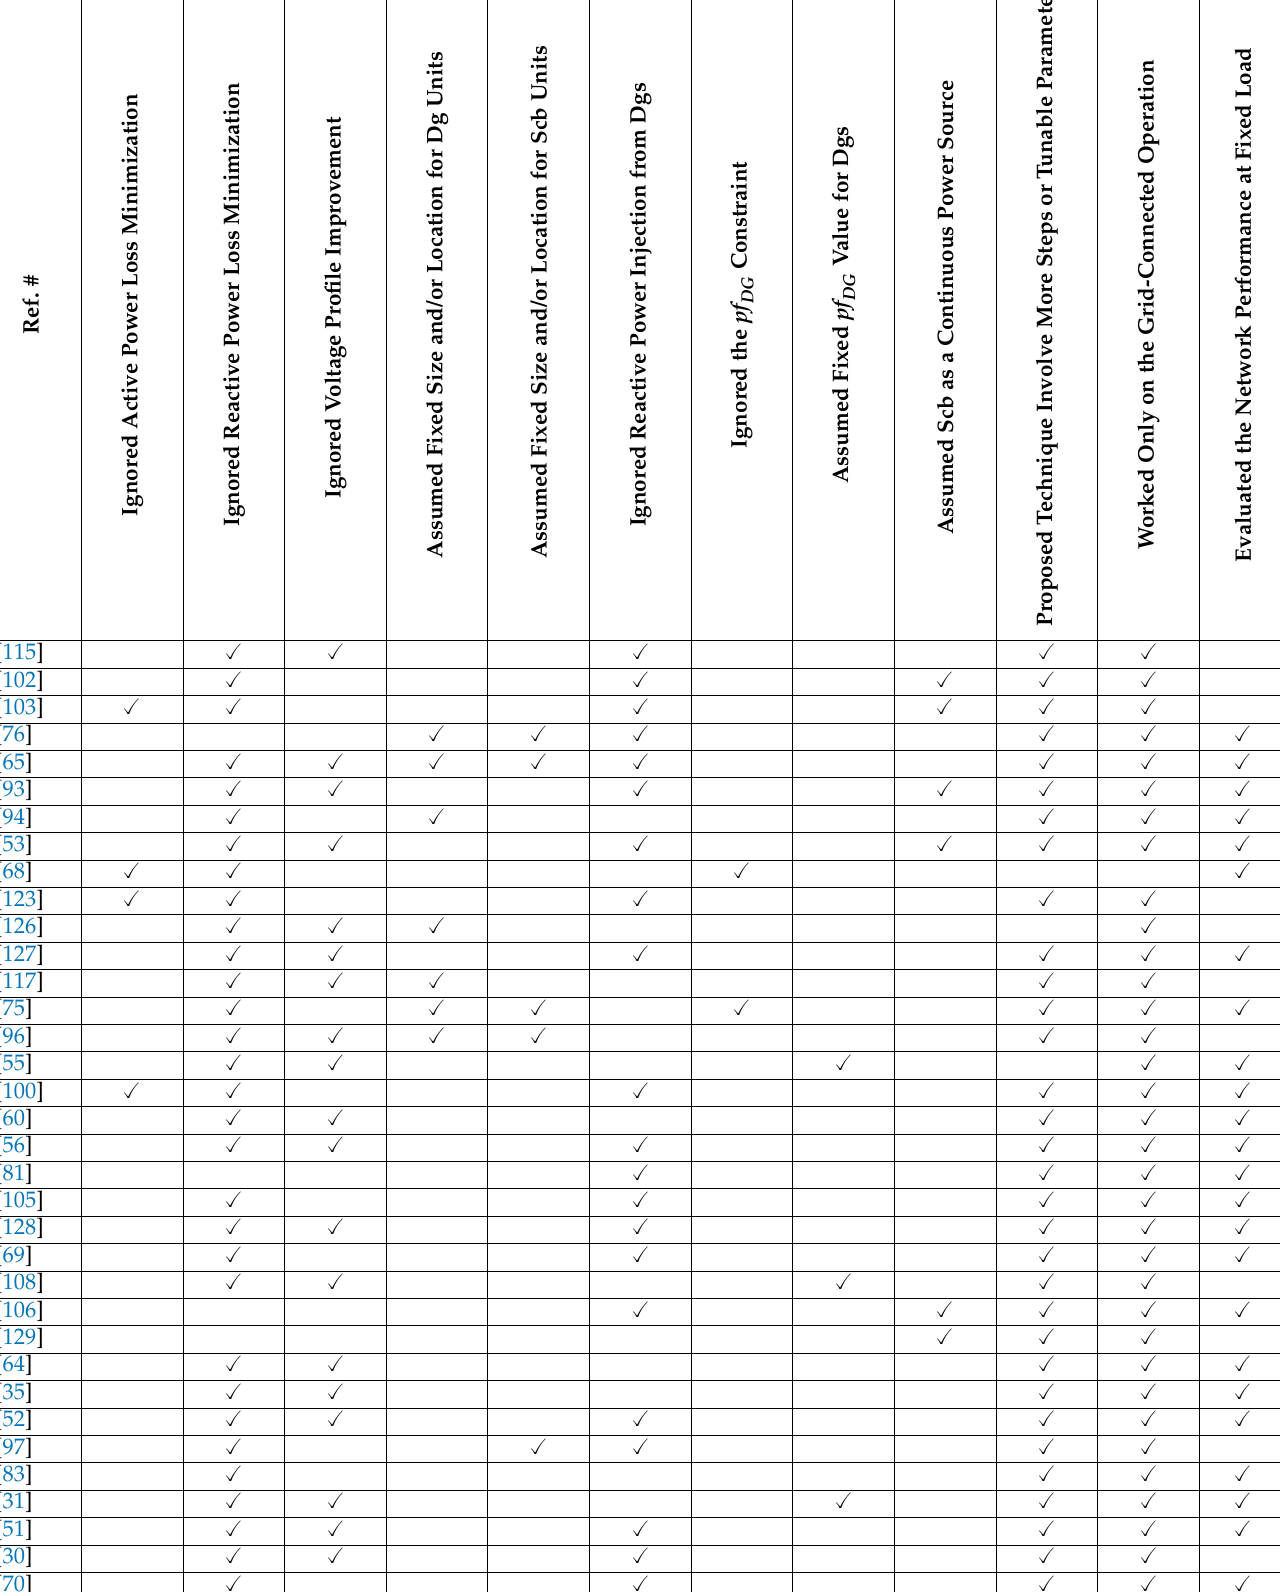
Table 5. Limitations of the existing optimization